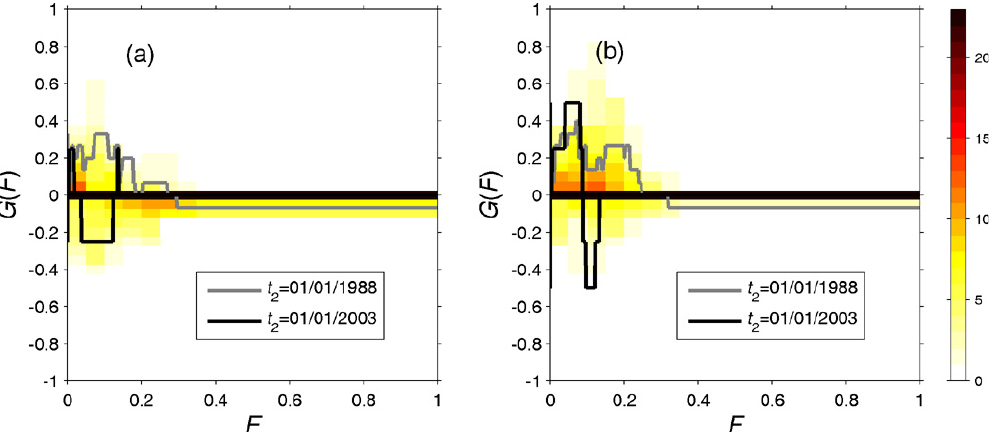
Fig. 5. (a) Difference between PI forecasts using “background events” and those using the whole event set. (b) Difference between PI forecasts using “background events” and those using “clustering events”. The gray line and black line represent the results of the first and the last sliding, respectively. The color bar indicates the stacking of the areas encompassed by the G curves and the horizontal zero-line.